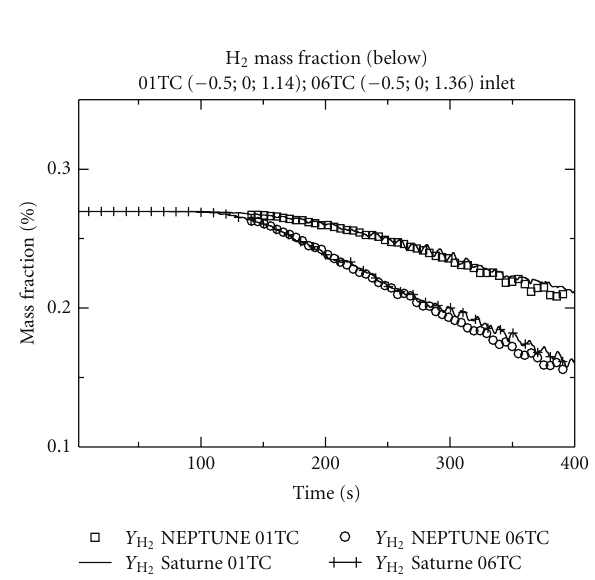
Figure 10: Stages, test number 008.